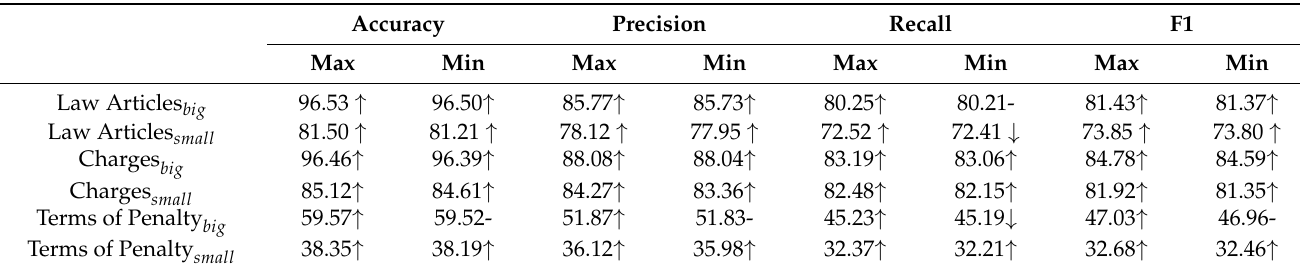
Table 6. Maximum and minimum values of LJP experimental